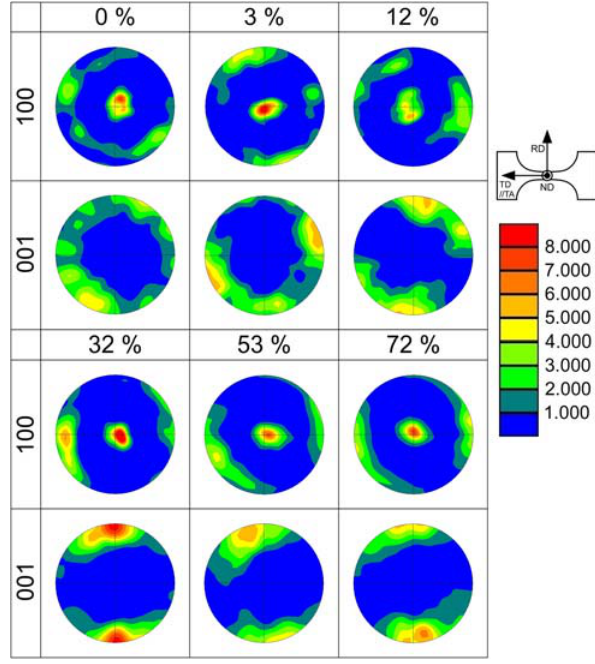
Figure 9: Fraction of misorientation angles of the LAGBs of Mo ss in the MoSiBTiC alloy crept at 1,500°C and 137 MPa with the creep strain.